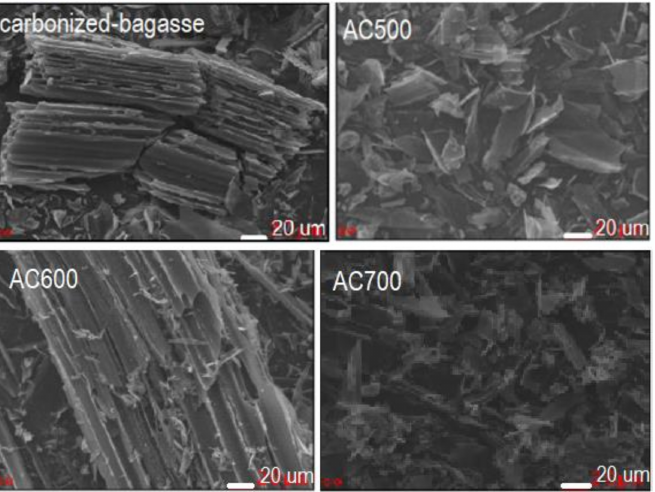
Figure 6. SEM images of the carbonized-carbon and the activated-carbon at 500 ◦ C (AC500), 600 ◦ C (AC600), 700 ◦ C (AC700).